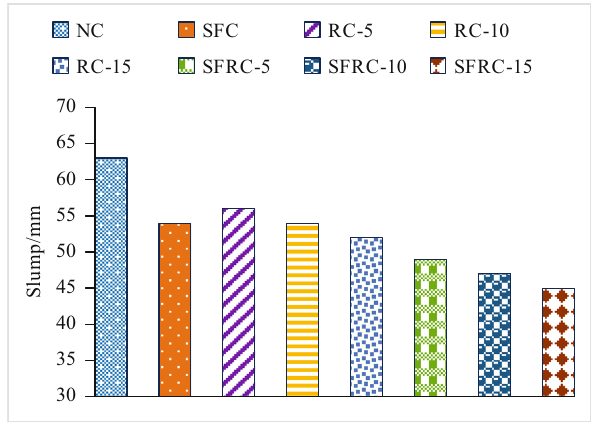
Figure 4: Slump test.